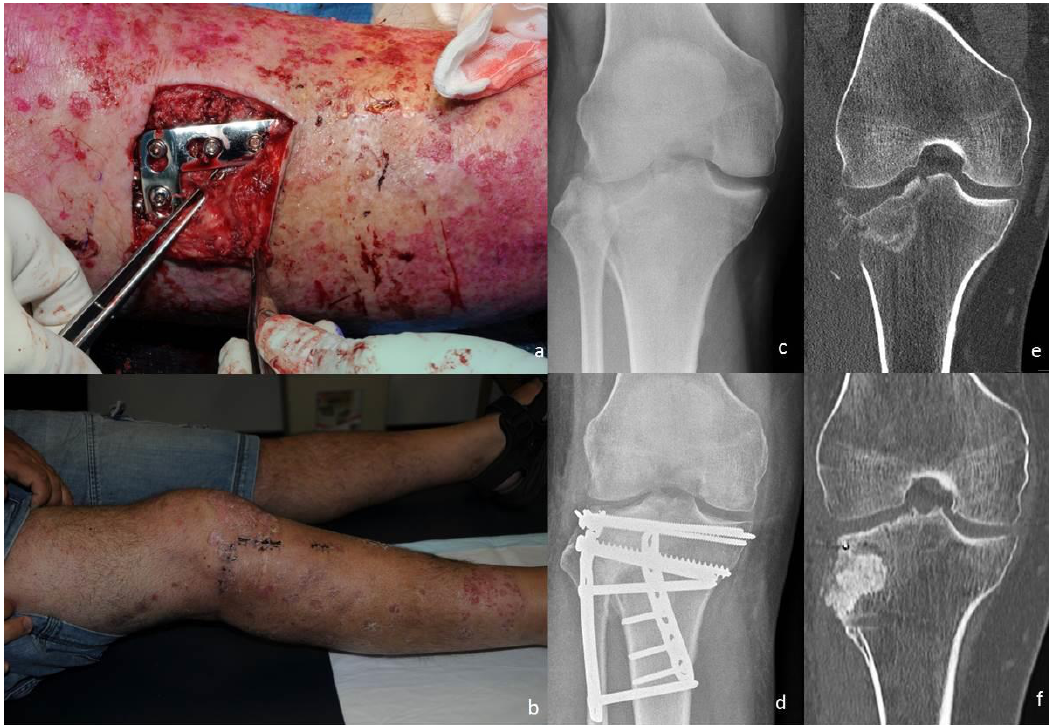
Figure 1. A tibial plateau fracture in a 40-year-old male with extensive florid psoriasis. The